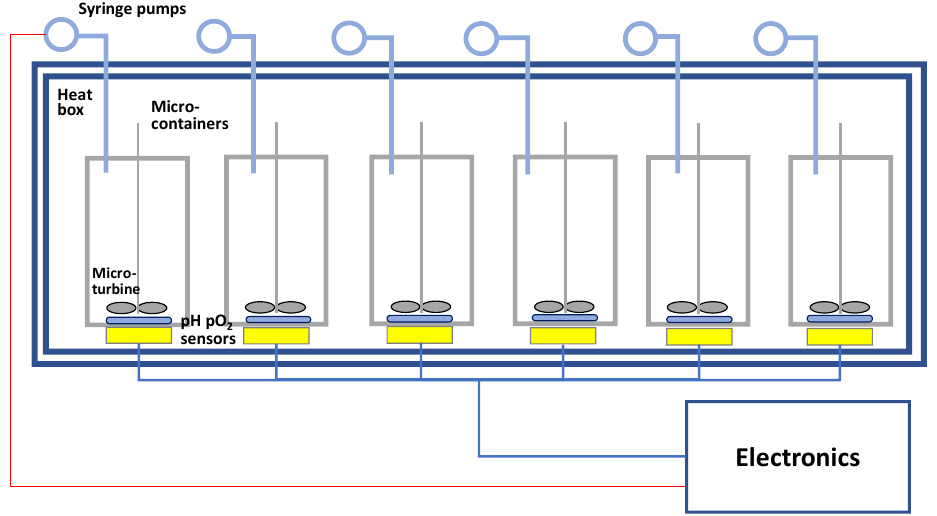
Figure 7. Blueprint of a prototype based on the ranking of components towards the need specifications. An MBR setup with six independent reactors for culture of CHO cells in 2 – 5 mL scale contained in a thermostat box. Sensors for pH and pO 2 measure online in each MBR.